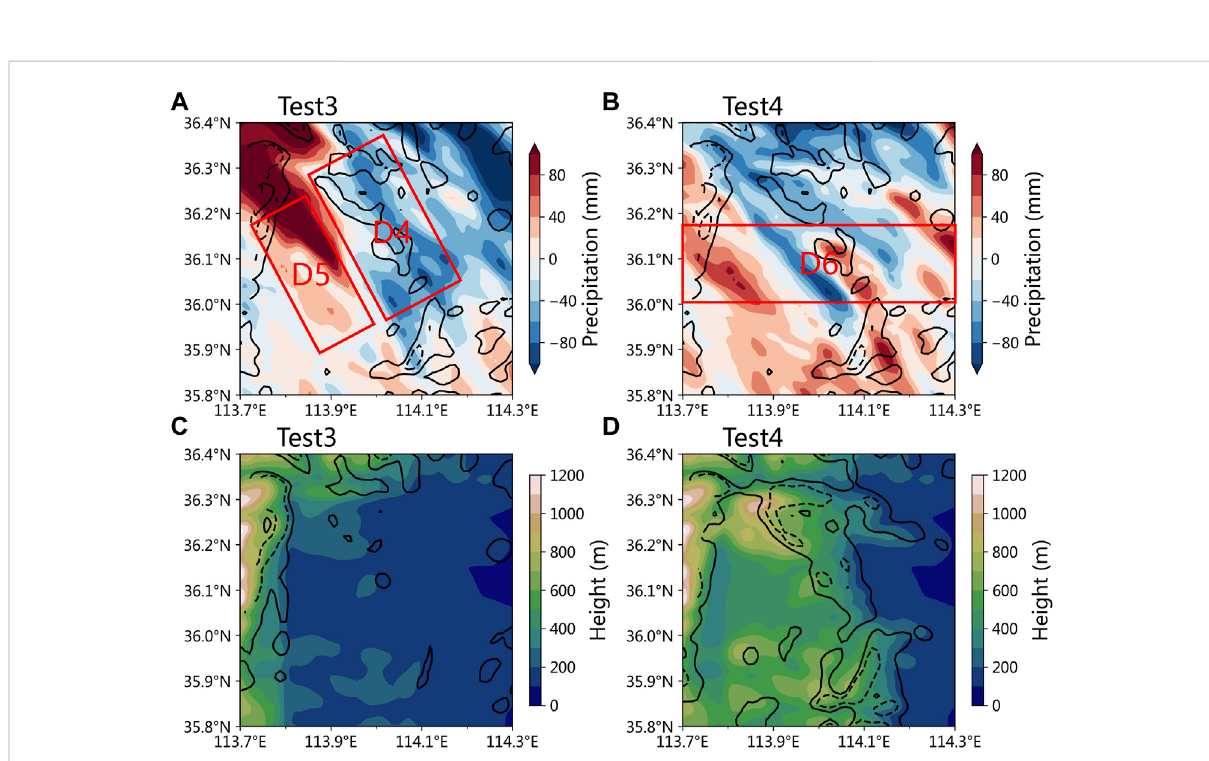
FIGURE 9 (A,B) Shaded regions indicate the difference in accumulated precipitation between the Test3 or Test4 experiment and the HighRes from 0000 UTC to 1200 UTC on July 19, 2016. The solid and dotted lines indicate the average vertical velocity forced by the terrain below 1,000 m in HighRes (contour; the interval is 0.1 m s − 1 for the solid line and 0.3 m s − 1 for the dashed line). (C,D) Shaded regions indicate the terrain height of the Test3 and Test4 experiments. The solid and dotted lines indicate the average vertical velocity forced by the terrain below 1,000 m in Test3 and Test4 experiments (contour; the interval is 0.1 m s − 1 for the solid line and 0.3 m s − 1 for the dashed